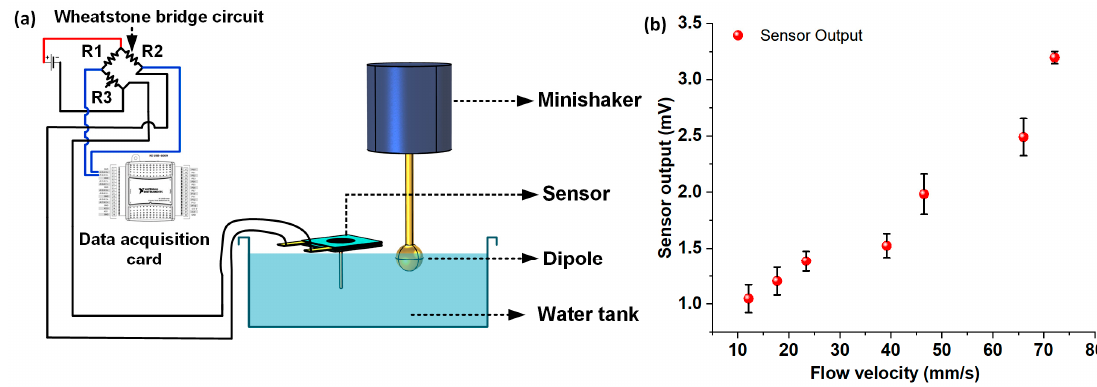
Figure 7. Oscillatory flow sensing characterization underwater: ( a ) Schematic representation of the experimental setup involving the dipole setup for oscillatory flow calibration; ( b ) Plot showing sensor output versus the oscillatory flow stimuli.